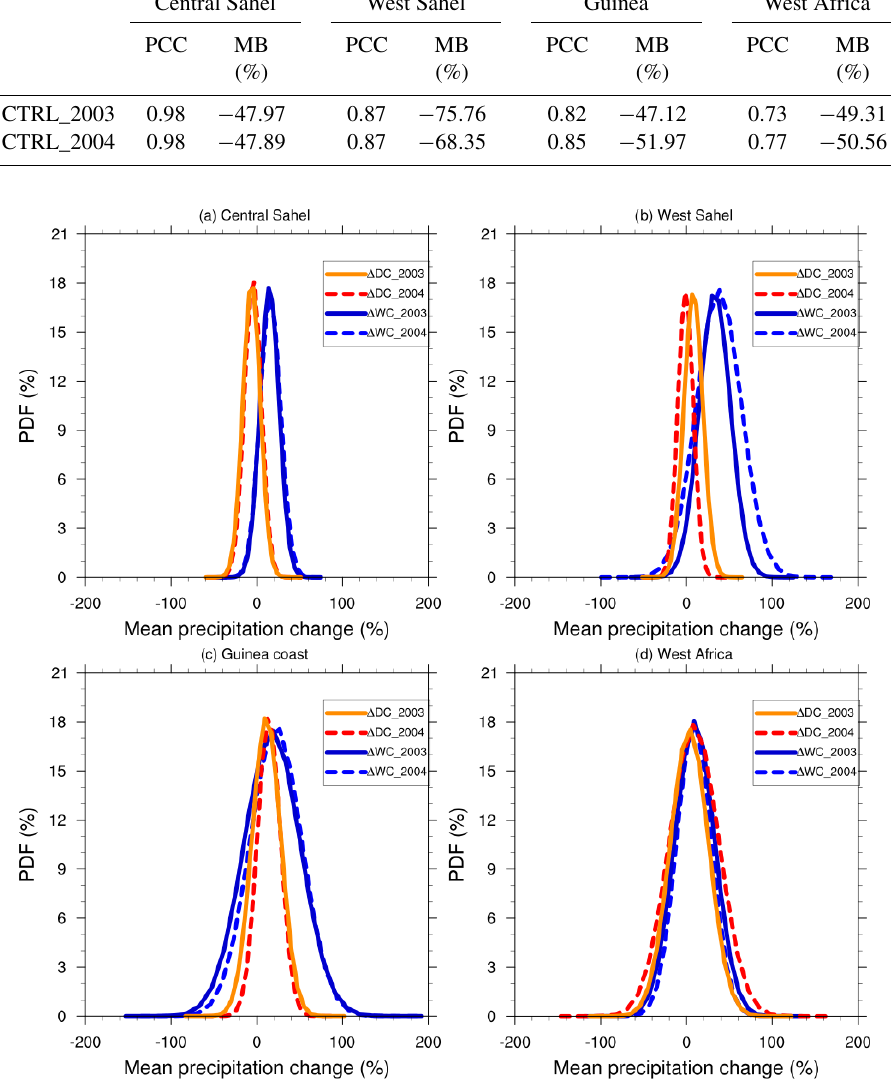
Table 1. The pattern correlation coefficient (PCC) and the mean bias (MB) values for JJAS precipitation for model simulations with respect to CHIRPS, calculated for the Guinea coast, Central Sahel, West Sahel and the entire West Africa domains during the 2003 and 2004 periods. Central Sahel West Sahel Guinea